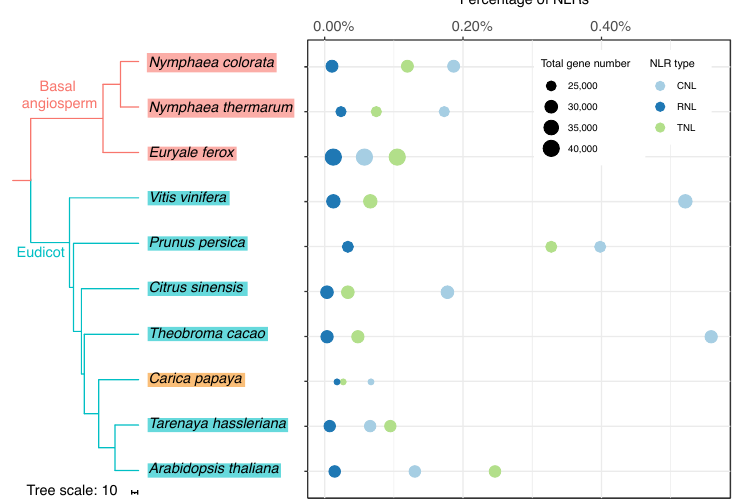
Figure 1. Phylogeny of papaya and selected species with the genome-wide proportion of NLRs (CNL%, RNL%, TNL%). Phylogenomic relationships of species refer to http://www.timetree.org (accessed on 15 November 2022) [29] and research of water lily genome